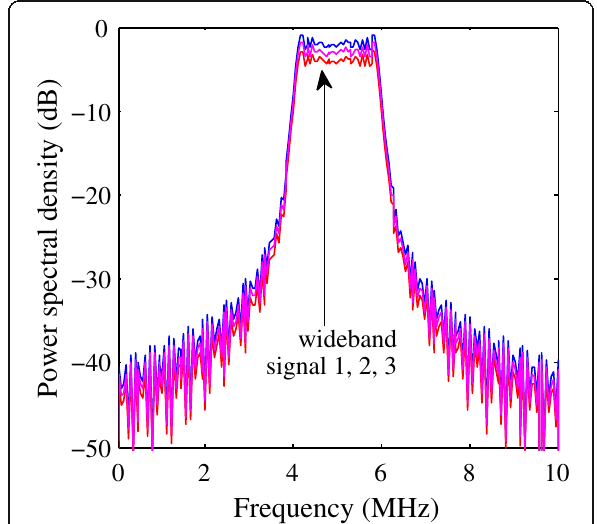
Fig. 1 Energy distribution of coherent LFM signals in the frequency